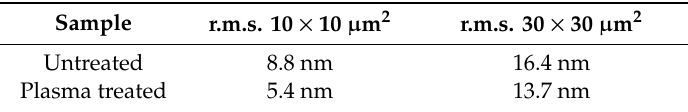
Table 3. Root mean square (r.m.s.) of the heights for untreated and plasma treated samples (peak power = 70 W, SF 6 pressure = 30 Pa, DC =